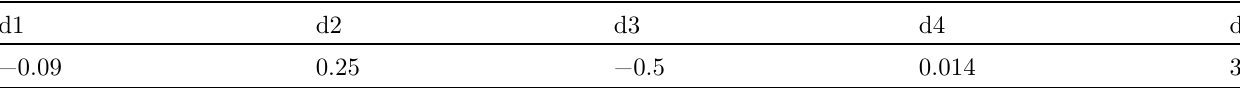
Table 2. Johnson-Cook failure parameter of Ti-6Al-4V alloy [24].